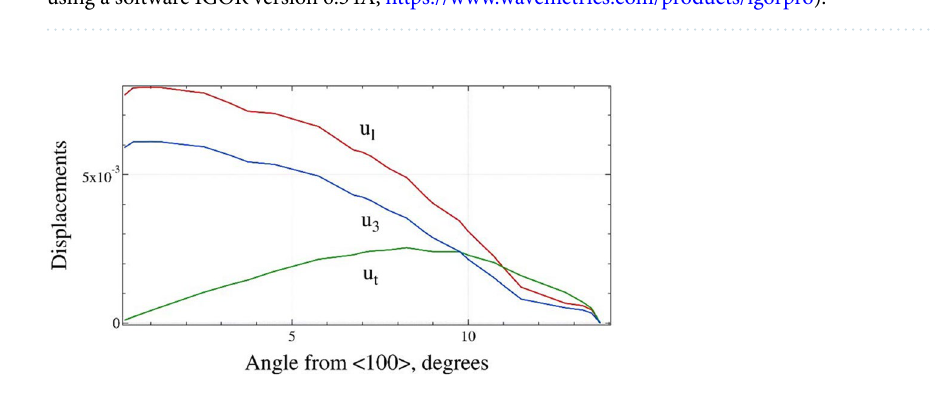
= 0 . (graph created x 3